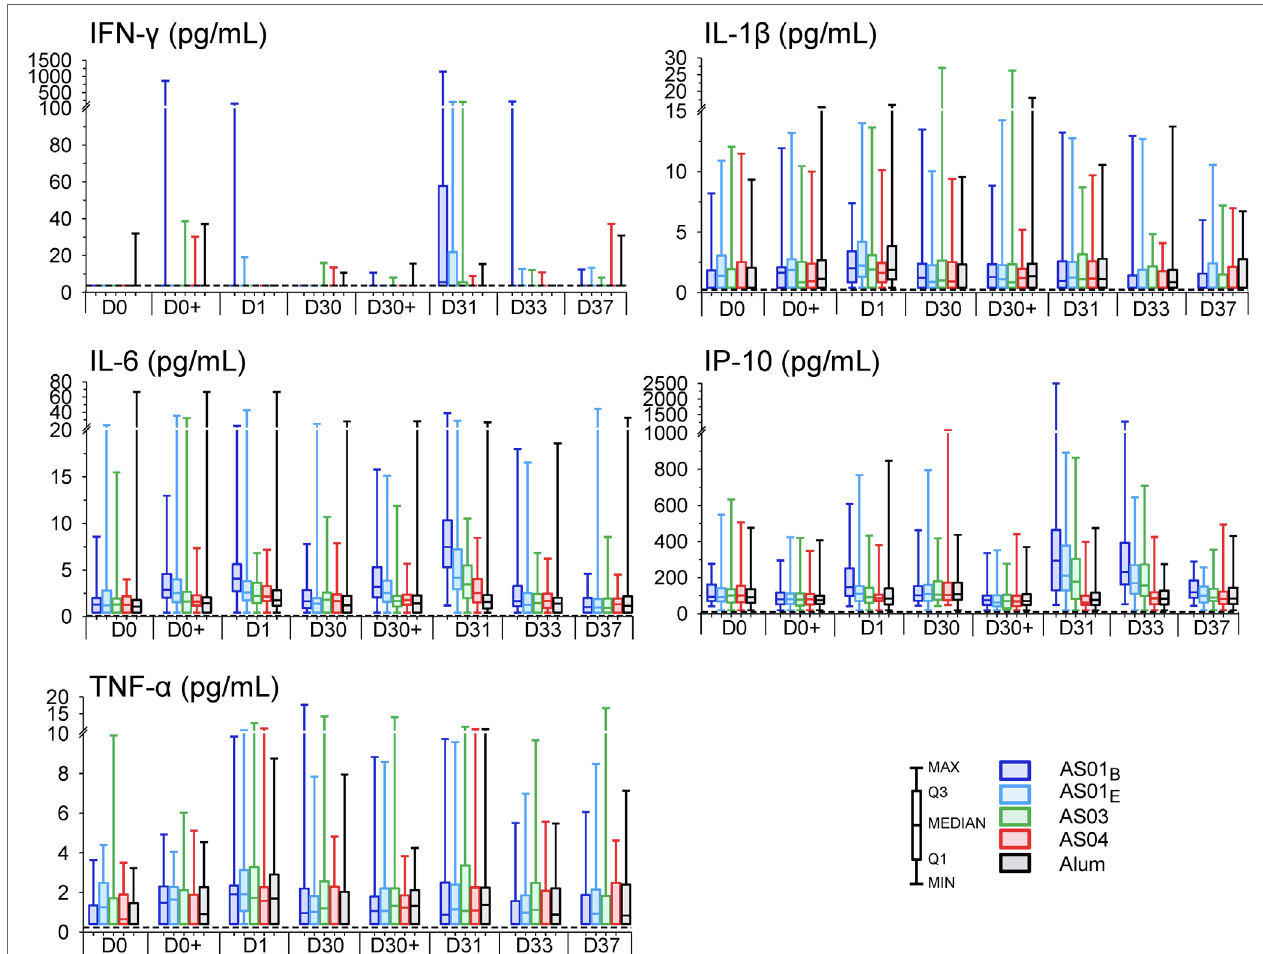
FiGUrE 3 | Innate cytokine responses. Interferon (IFN)- γ , interleukin (IL)-1 β , IL-6, induced protein (IP)-10, and tumor necrosis factor (TNF)- α concentrations for the AS01 B , AS01 E , AS03, AS04 or Alum groups of the per-protocol cohort for innate immunogenicity (N = 59, 57, 59, 61 and 55, respectively) are represented in box-whisker plots with medians, interquartile ranges, minima and maxima indicated. The dotted lines indicate the assay